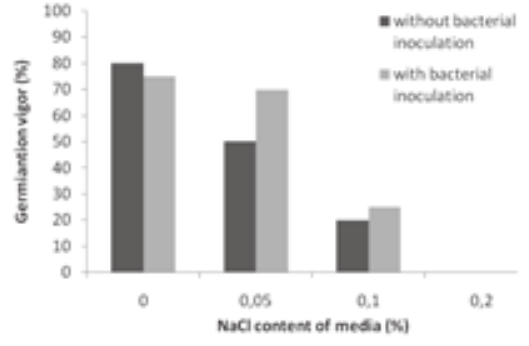
Fig. 5: Germination percent of Radish seeds on solid medium supplemented by different NaCl concentrations in presence of isolated bacterium